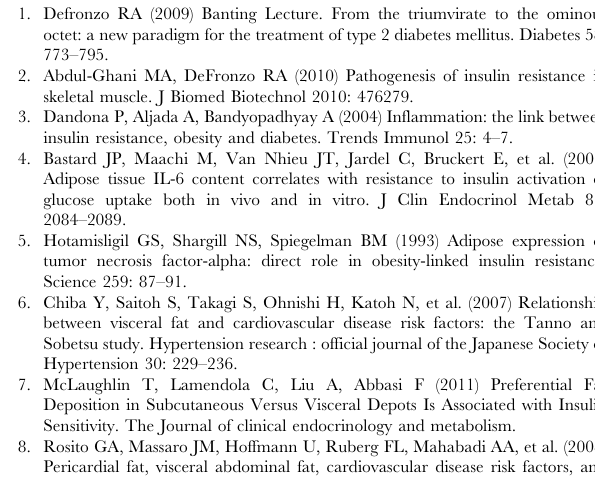
Table S1 Expression values for genes changed greater than 2 fold between 6 vs. 0 months, no omentectomy; 12 vs. 0 months, no omentectomy; 6 vs. 0 months with omentectomy; and 12 vs. 0 months, with omentectomy. (PDF) Table S2 Expression values for genes changed greater than 4 fold between 6 vs. 0 months, no omentectomy; 12 vs. 0 months, no omentectomy; 6 vs. 0 months with omentectomy; and 12 vs. 0 months, with omentectomy. Table S3 TLDA probes utilized in this study. Table S4 Average gene expression values for those molecular interaction members within the indicated molecular pathway. Pathways are ranked highest to lowest in terms of the number of genes detected per